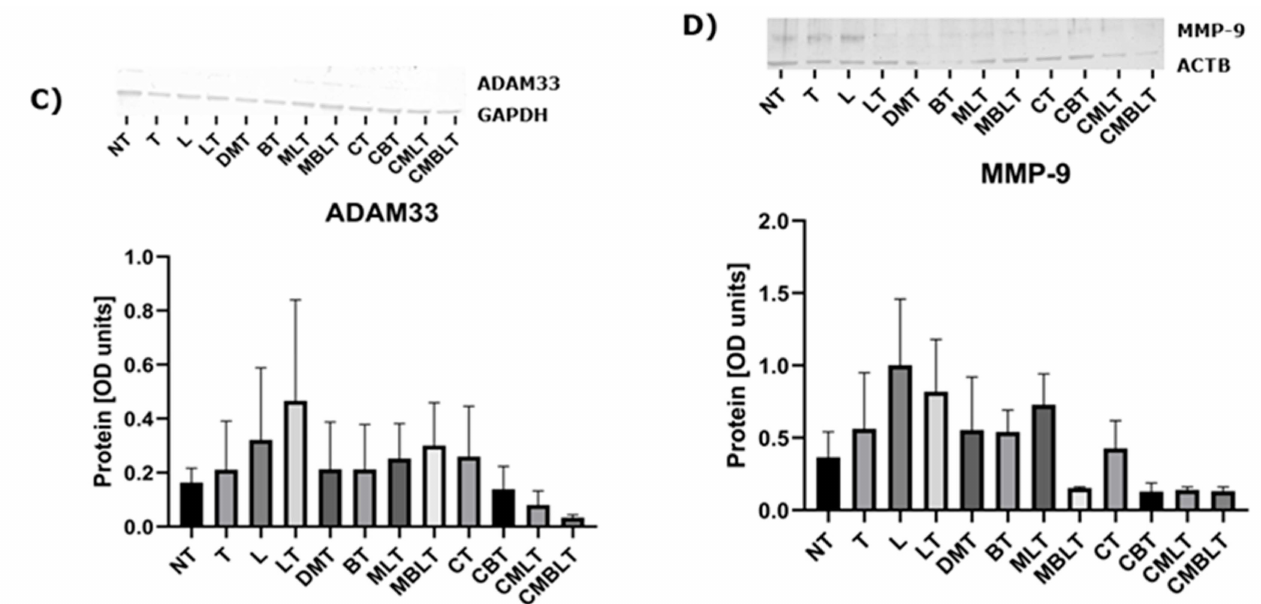
Figure 3. Calcitriol, beclomethasone 17-propionate and montelukast sodium effect on the expression of Vimentin, ADAM33 and MMP-9. ( A , B ) mRNA expression and ( C , D ) protein level of ADAM33 and MMP-9 after exposure to calcitriol, beclomethasone 17-propionate, montelukast sodium, LTD4 and TGF- β . The results of experiments (n = 3) are presented in relation to GAPDH or ACTB as mean ± SEM. Western blots are shown for genes, in which the statistical significance has been observed at the mRNA level. Original Western blots can be found at Figure S1. @ p < 0.05, @@ p < 0.01 versus NT group; # p < 0.05, ## p < 0.01 versus T group; $ p < 0.05 versus L group; % p <